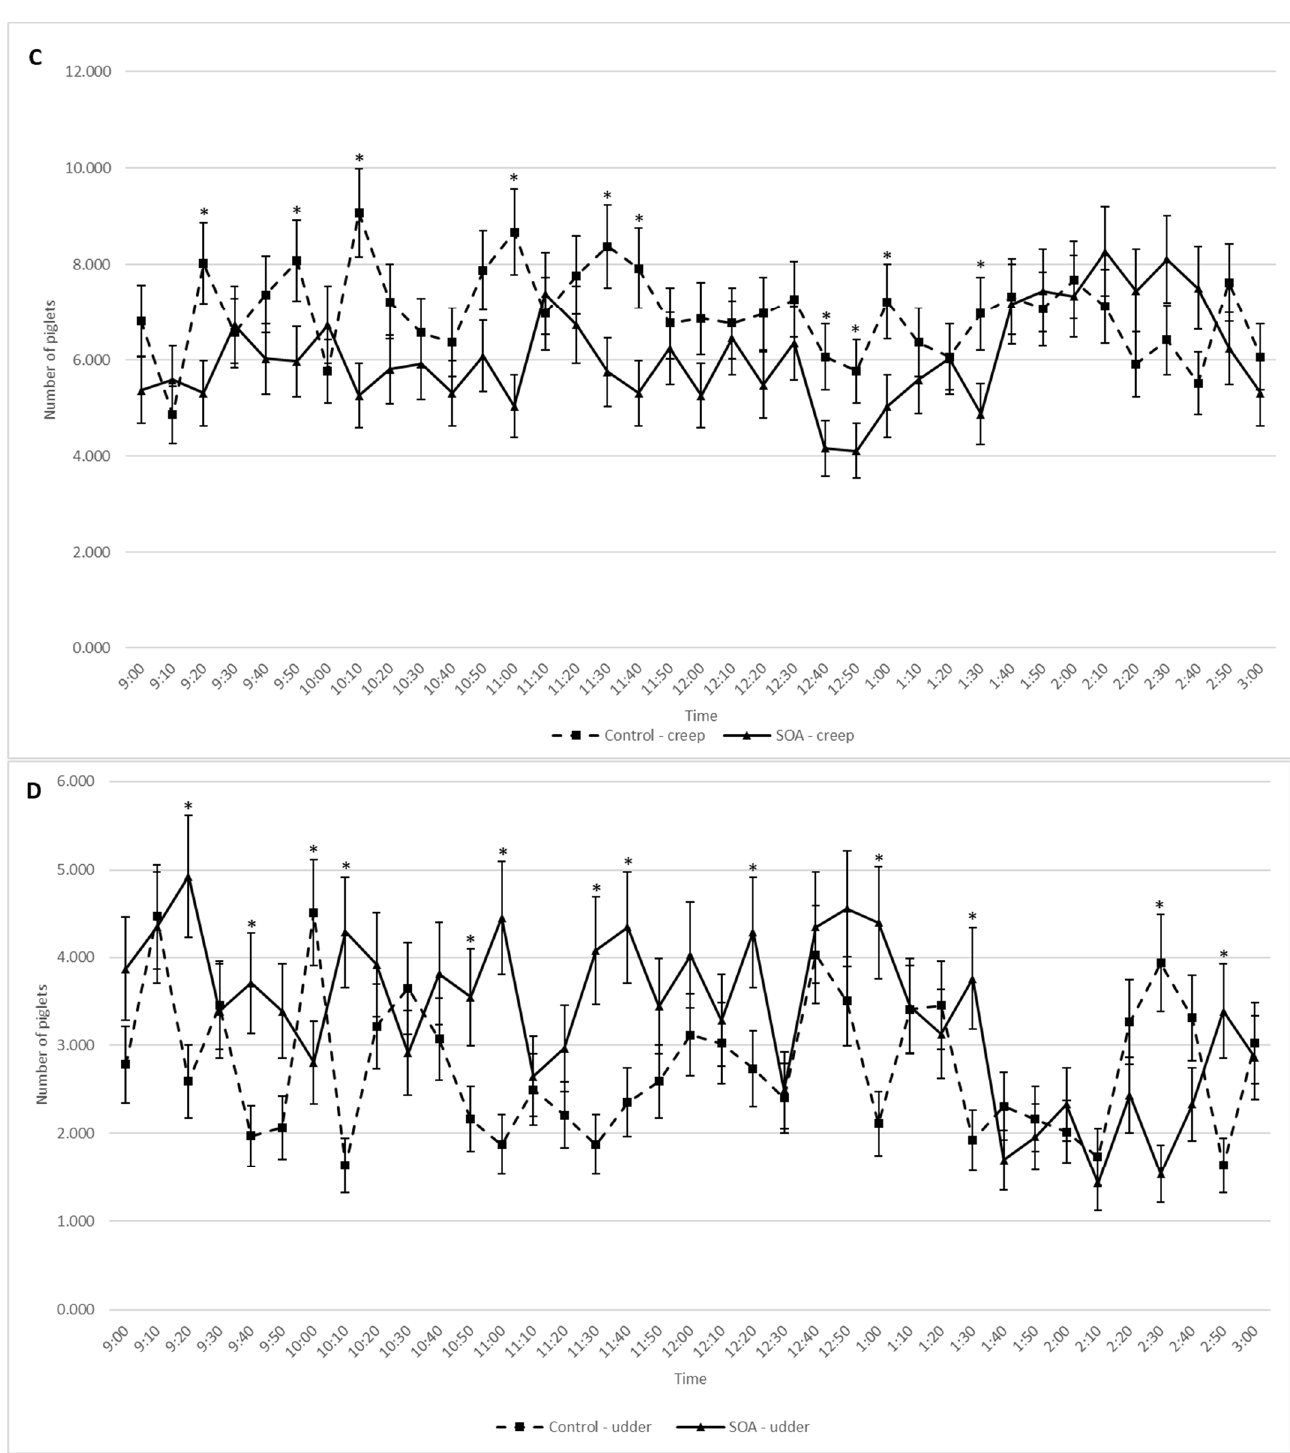
Figure 3. Mean ± SEM number of piglets in the creep area on day 2 of age ( A ). Mean ± SEM number of piglets next to the udder on day 2 of age ( B ). Mean ± SEM number of piglets in the creep area on day 3 of age ( C ). Mean ± SEM number of piglets next to the udder on day 3 of age ( D ). The number of piglets in either location was recorded every 10 min from video analysis from 9 a.m. to 3 p.m. * indicates significant difference between treatments at a given timepoint ( p < 0.05).